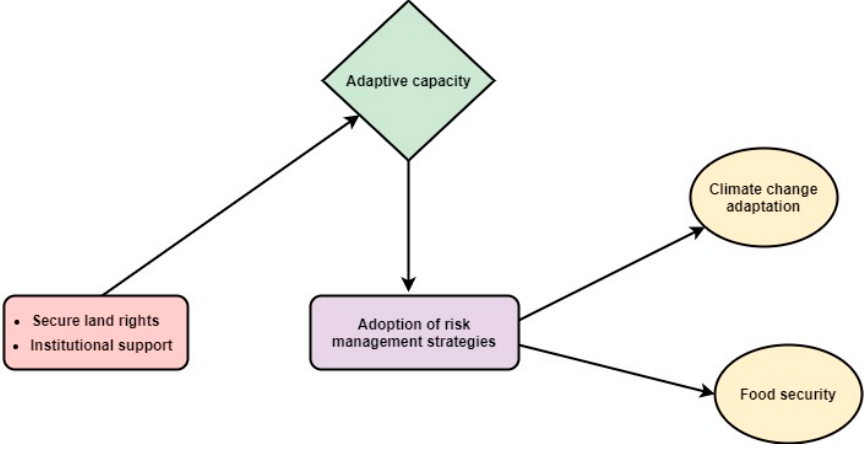
Figure 8. Policy implementation framework.